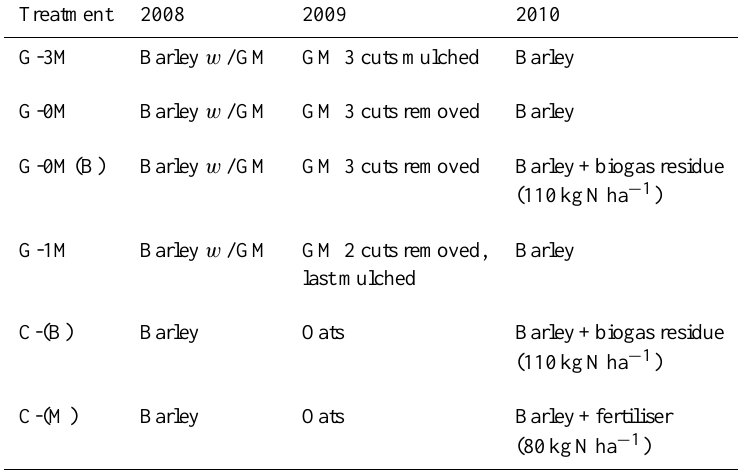
Table 2. Treatments in the 3-yr crop rotation. N 2 O emissions were measured during the vegetation periods of 2009 and 2010. The field was spring ploughed and sown in 2008. Cereal reference plots were also ploughed in spring 2009. All plots were ploughed on 23 April and sown on 14 May 2010 with barley. Biogas residue and mineral fertiliser was applied on 12 May 2010. Treatment 2008 2009 2010 G-3M Barley w /GM GM 3 cuts mulched Barley G-0M Barley w /GM GM 3 cuts removed Barley G-0M(B) Barley w /GM GM 3 cuts removed Barley+biogas residue (110kgNha − 1 ) G-1M Barley w /GM GM 2 cuts removed, Barley last mulched C-(B) Barley Oats Barley+biogas residue (110kgNha − 1 ) C-(M) Barley Oats Barley+fertiliser (80kgNha − 1 ) G-3M=grass-clover herbage mulched, G-0M=grass-clover herbage removed, G-0M(B)=grass-clover herbage removed in 2009 and partly applied as biogas slurry in 2010, G-1M=first two cuts of grass-clover herbage removed, last cut mulched, C-(B)=cereal reference with biogas residue application in 2010, C-(M)=cereal reference with mineral fertiliser application in